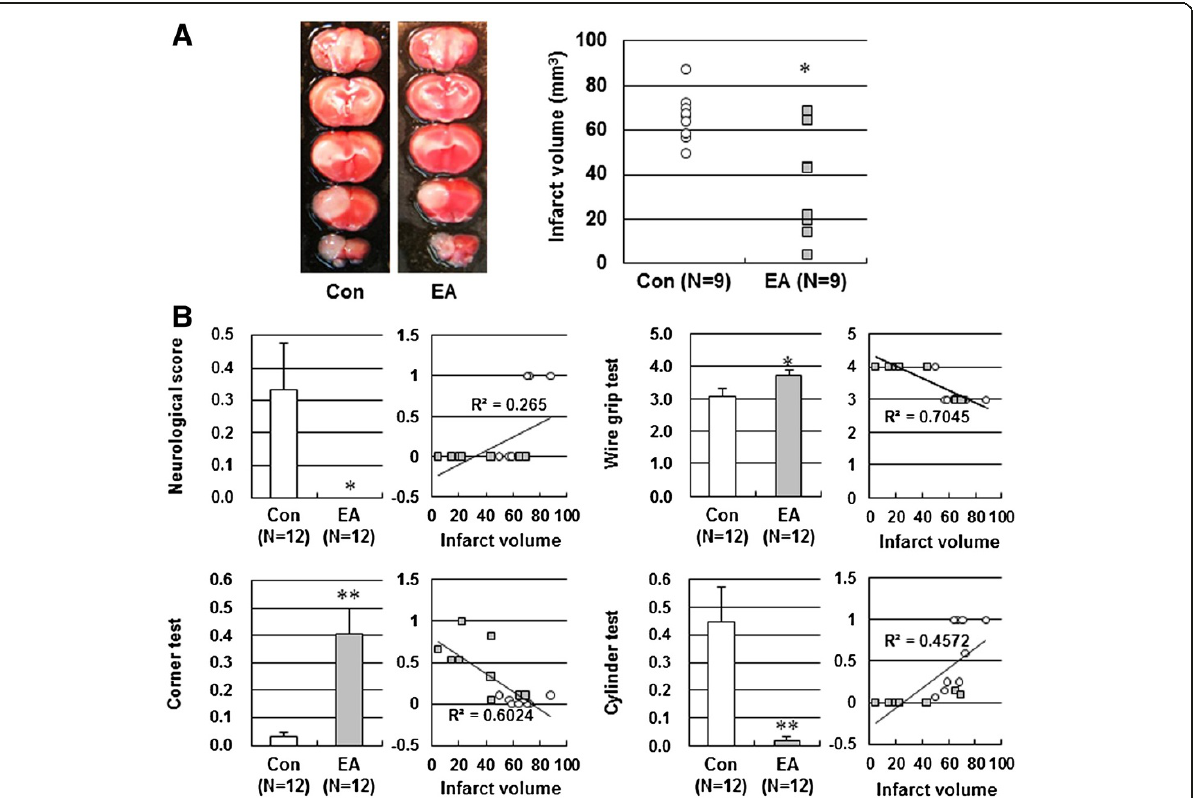
Figure 3 Effect of EA preconditioning on tissue and functional outcome. (A) Representative photographs of coronal brain sections following infarction stained with 2,3,5-triphenyltetrazolium chloride. The red area is healthy tissue and the white area is infarct tissue. * , P <0.05 vs. control (Con). (B) Neurological deficit and motor deficit were assessed 24 h after ischemia. Neurological function was assessed by neurological score, vestibule-motor function by a wire grip test, sensori-motor function by a corner test and asymmetry forelimb use for weight shifting by a cylinder test. A regression line showed the relationship between tissue injury (infarct volume) and functional outcome (neurological score, wire grip test, corner test and cylinder test). Results are expressed as mean ± SEM for twelve mice in each group. * , P <0.05 and ** , P <0.01 vs. control